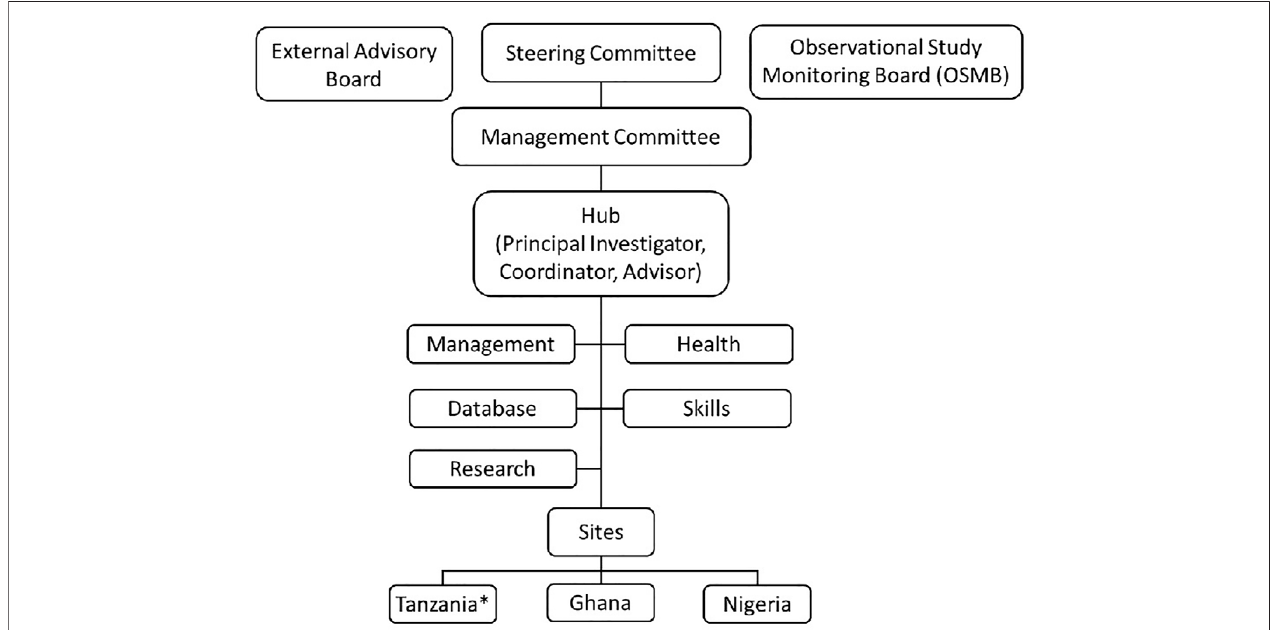
FIGURE 2 | The Organizational Structure of the Sickle Pan African Research Consortium